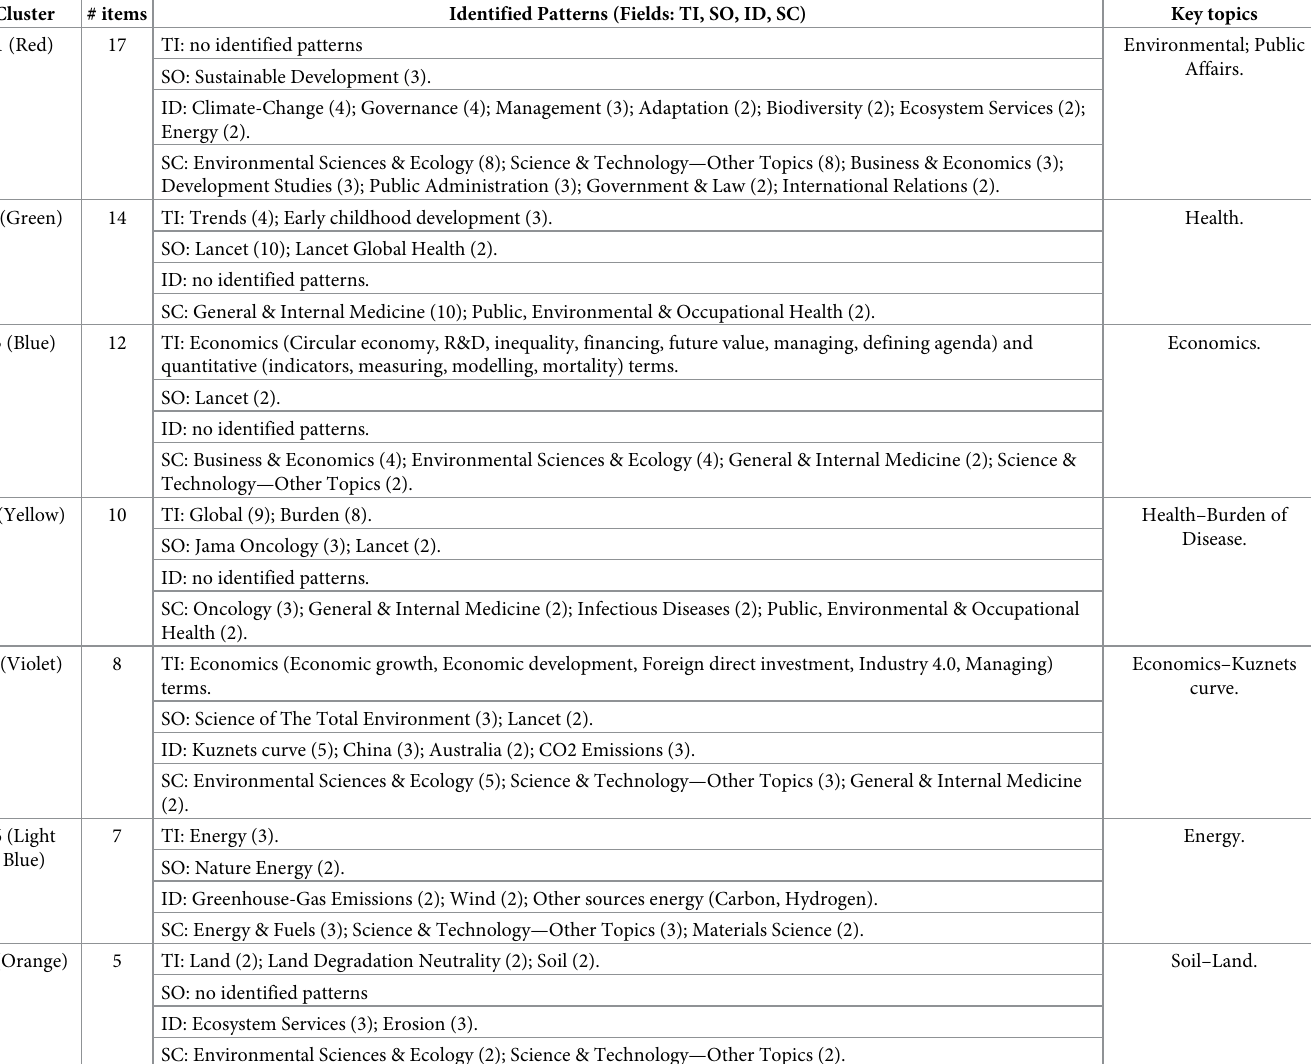
Table 7. Articles according to coupling-citation